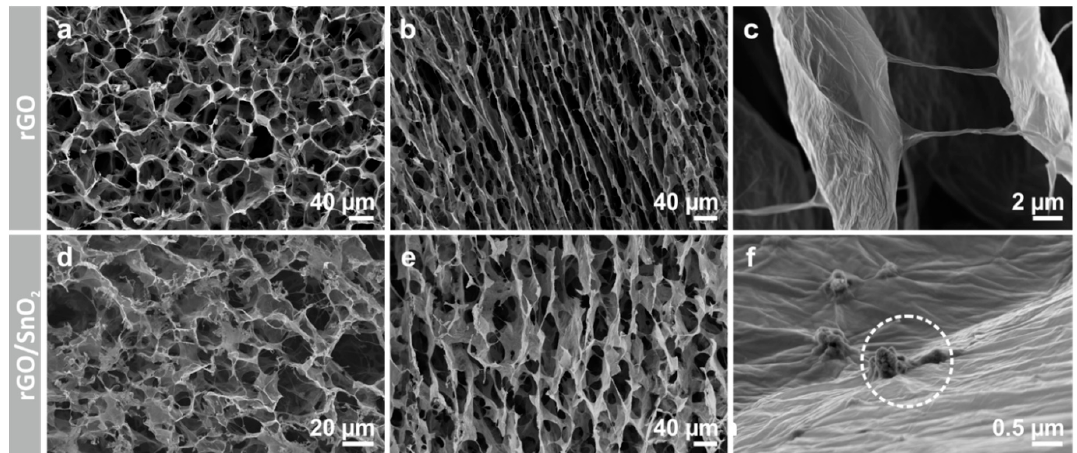
Figure 2. SEM images of the microstructures of rGO and rGO / SnO 2 aerogels ( a , d ) top view and ( b , e ) side view of the channels. Detailed view of the ( c ) GO walls and ( f ) the SnO 2 nanoplatelets embedded in the walls.